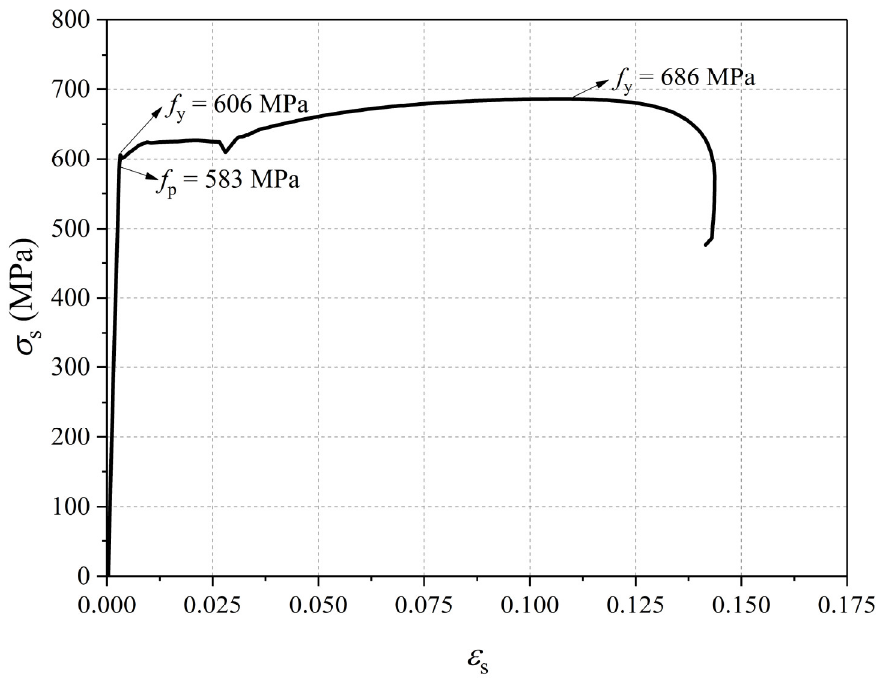
Figure 19. Stress-strain relationship of Q420 steel.